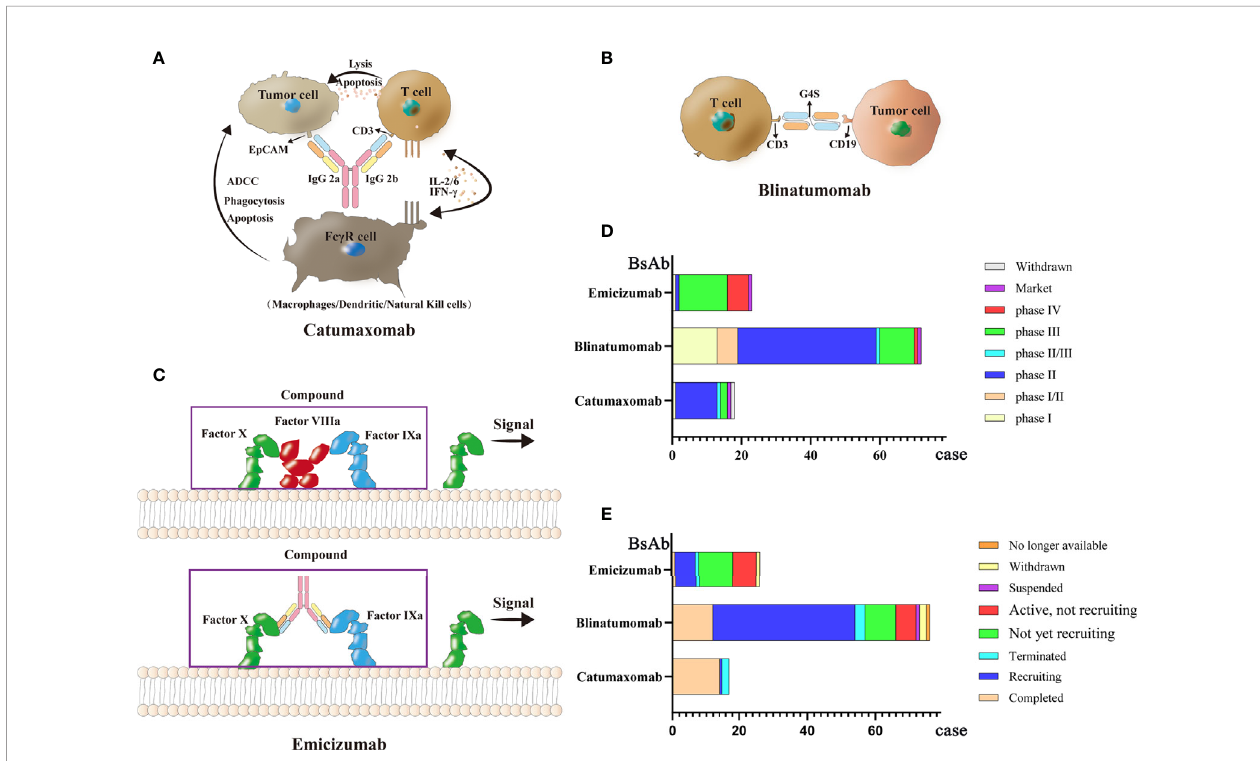
FIGURE 3 | Mechanisms and clinical study of three market BsAbs: (A) Catumaxomab (B) Blinatumomab (C) Emicizumab (D) phase of three market BsAbs (E) status of three market